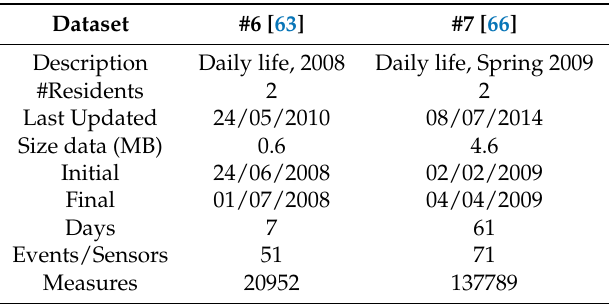
Table 3. CASAS datasets with two residents used for multi-user scenario algorithm.